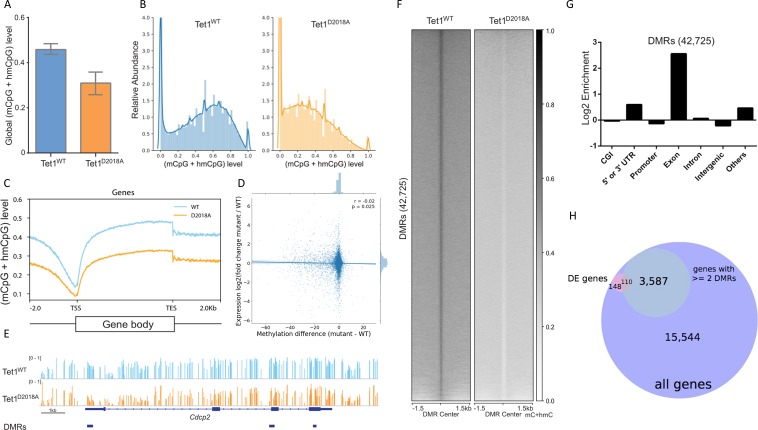
Whole genome bisulfite sequencing of WT and D2018A mESCs.(A) Genome-wide levels of mCpG +hmCpG. (B) Distribution of mC +hmC levels for individual CG sites fitting with kernel density estimate (KDE). (C) Distribution of averaged mCpG +hmCpG level at all genes. (D) Scatter plot of difference (D2018A - WT) in average CpG methylation in a 500 bp window around each promoter vs. log2 fold change (D2018A/WT) of corresponding genes. (E) An example of hypo CG-DMRs in exons of Cdcp2 gene in D2018A mESCs. (F) Average mCpG +hmCpG level ((h)mCG/CG) of individual ranked DMRs and flanking regions (±1.5 kb). (G) Genomic annotations of hypo CG-DMRs in D2018A mESCs. CGI: CpG island. (H) Overlap between DEGs and the set of genes with ≥ 2 DMRs between the gene's start and end sites (hypergeometric p value = 1.770e-19).